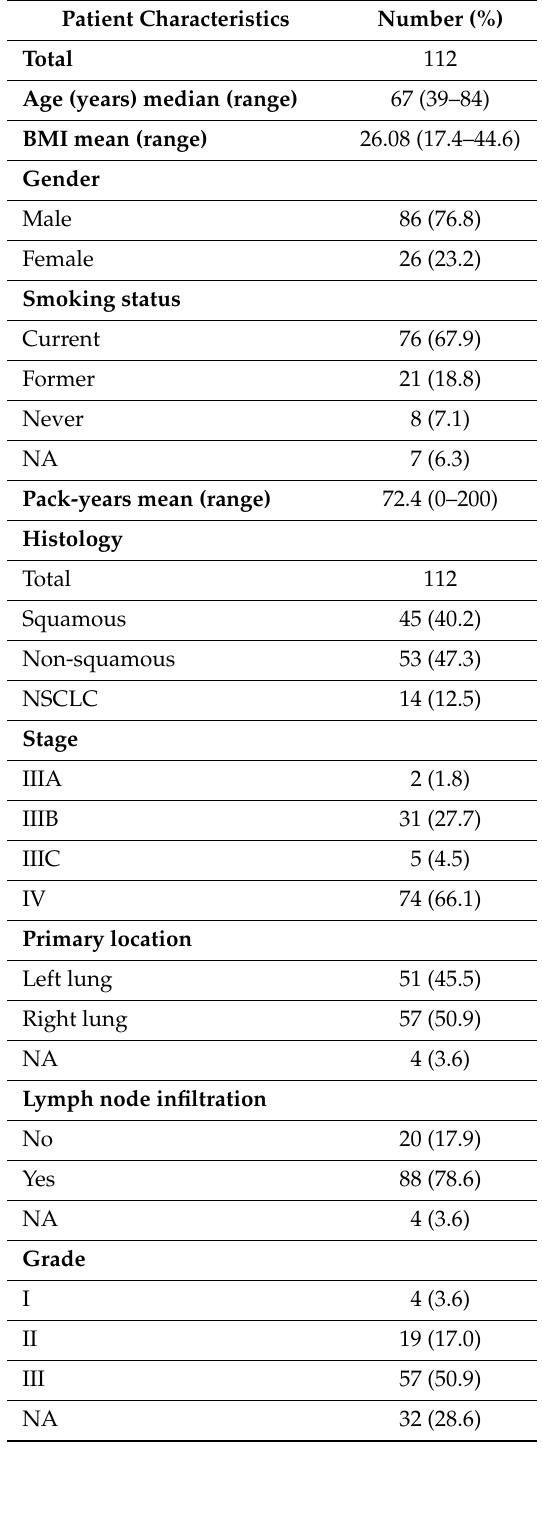
Table 1. Characteristics of NSCLC patients enrolled in the current